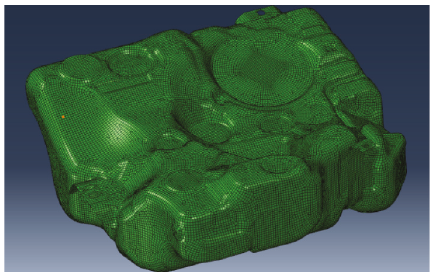
Figure 2: Fuel tank structure diagram.